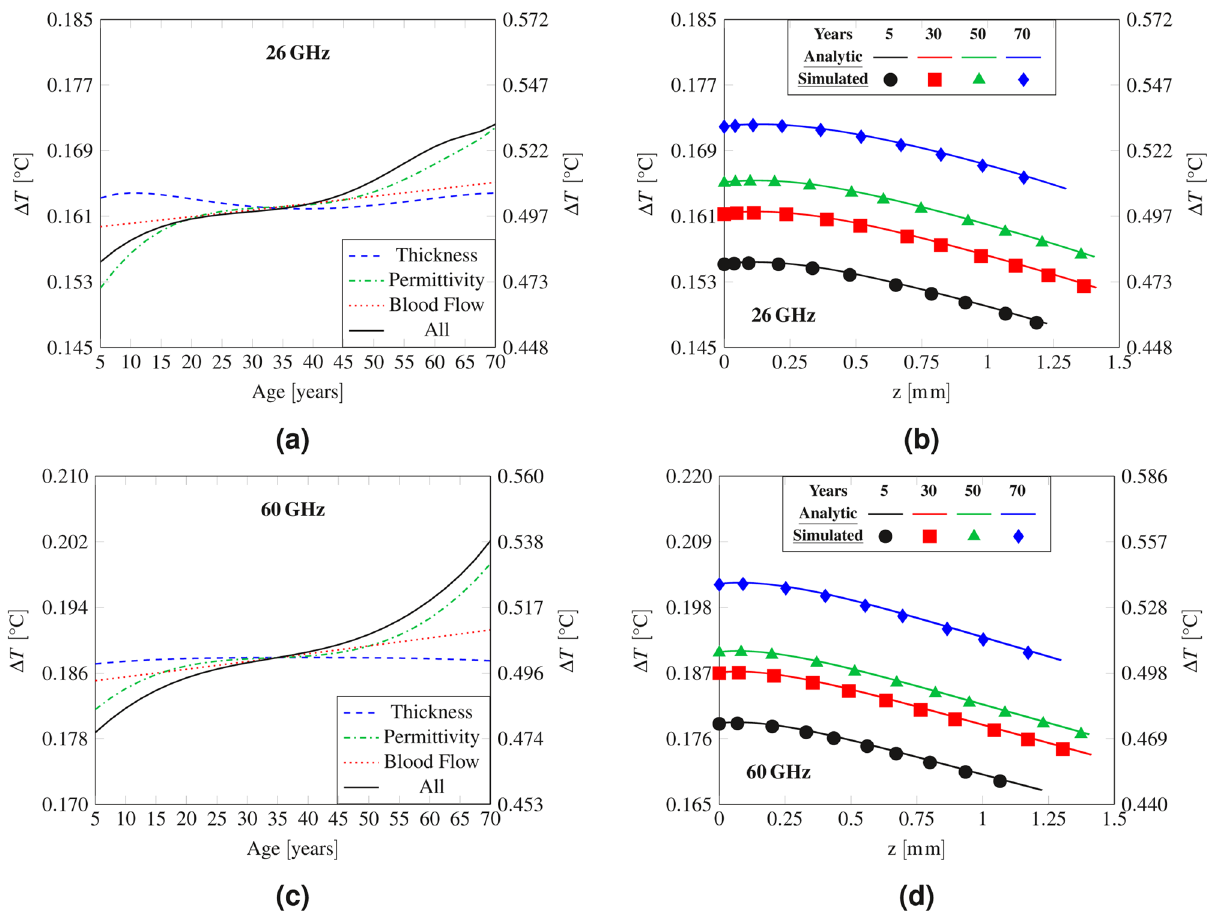
Figure 5. ( a , c ) Peak steady-state temperature elevation in skin as a function of age, ( b , d ) temperature elevation as a function of depth. The left y axis refers to the case of IPD equal to 10 W m − corresponds to the frequency-dependent IPD limits for local